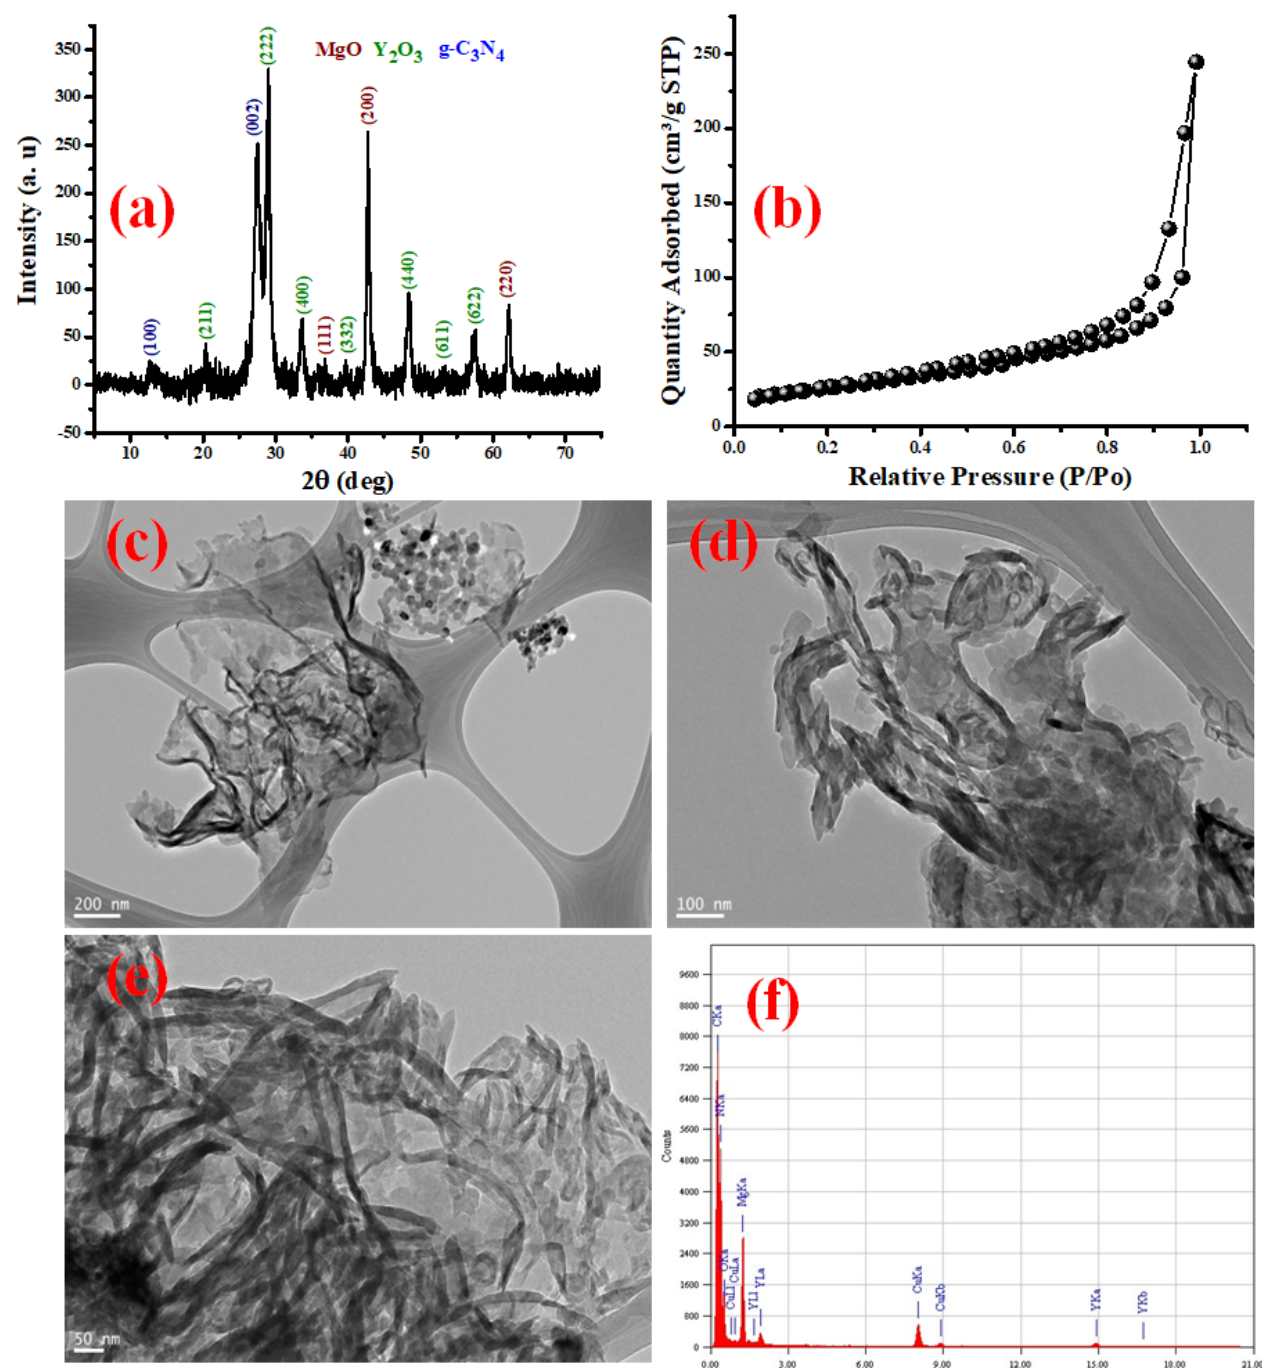
Figure 1. ( a ) XRD pattern; ( b ) BET surface area graph; ( c – e ) TEM images with different magnifications; and ( f ) EDX of MgY 2 O 4 @g-C 3 N 4 nanomaterials.